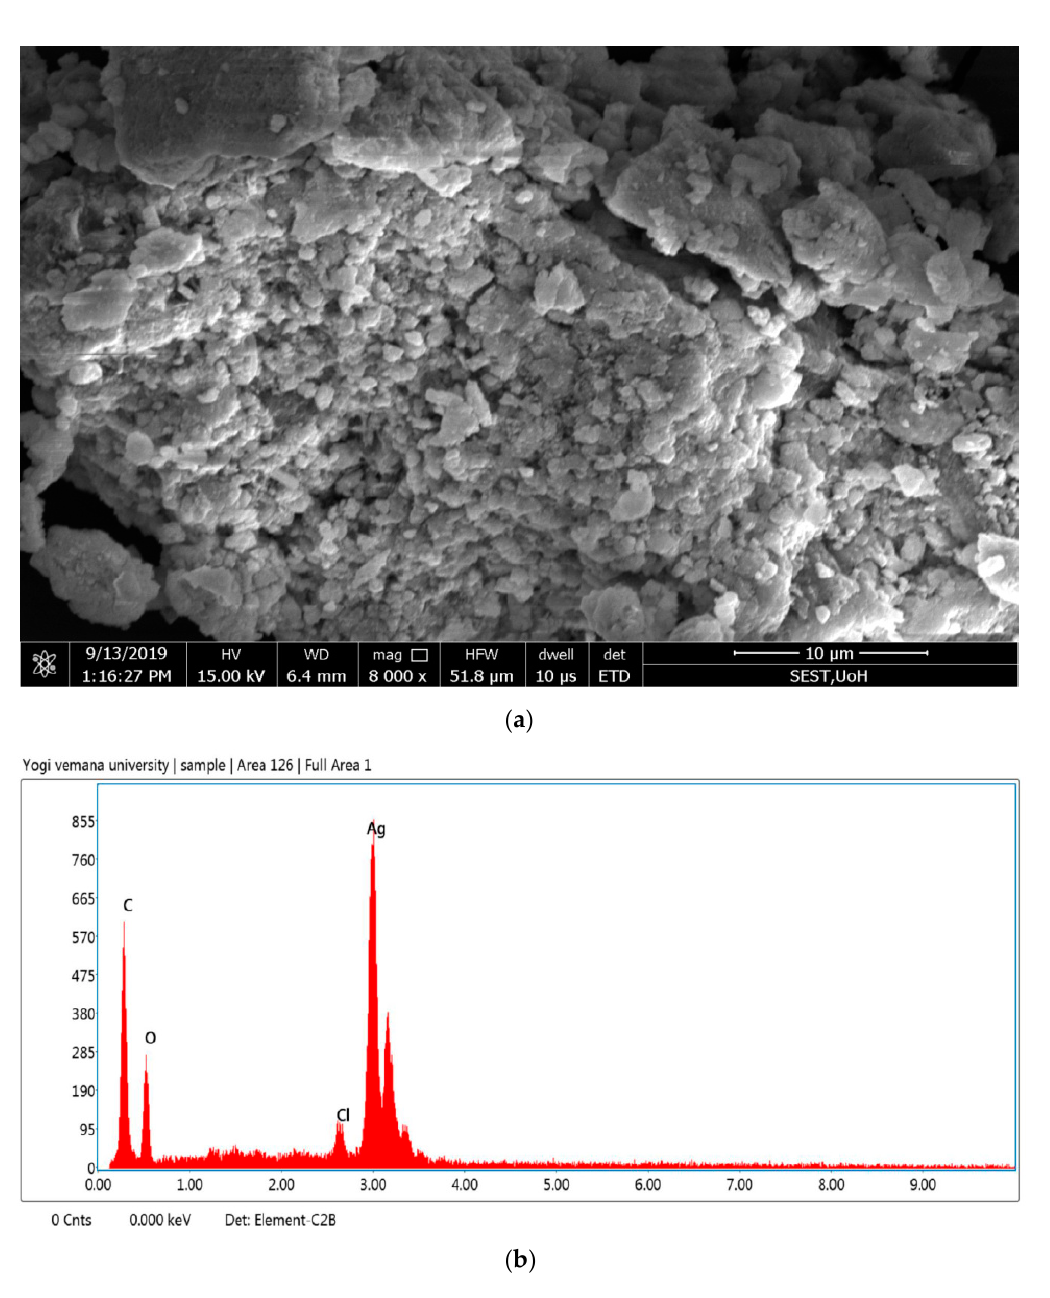
Figure 5. ( a ) Scanning electron microscopy (SEM) images of synthesized Ag NPs from Azadirachta indica ; ( b ) energy dispersive X-ray (EDX) spectrum of A Ag NPs showing the presence of different phytoelements as capping agents.